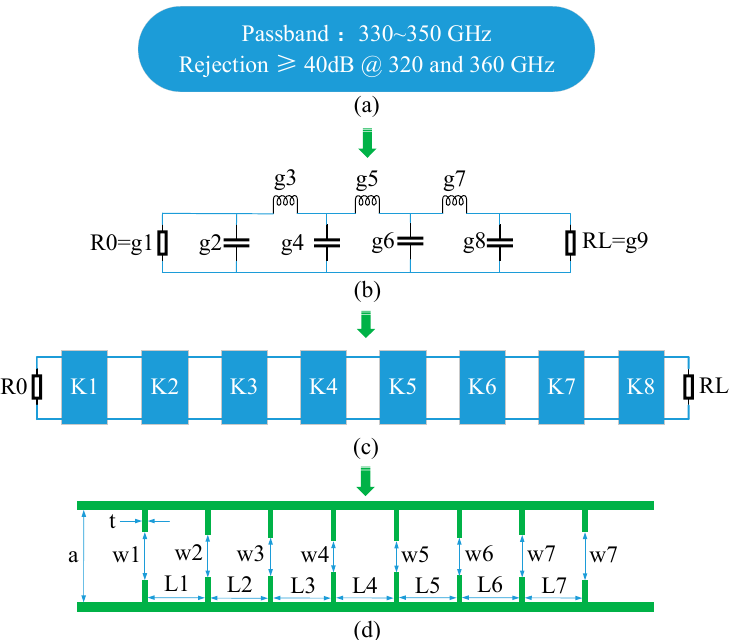
Figure 1. Design flowchart of 340 GHz terahertz filter. ( a ) Required technical indicators; ( b ) Prototype circuit of the 7-order Chebyshev response low-pass filter; ( c ) K-invert converters; ( d ) 7-order inductive diaphragm waveguide filter.